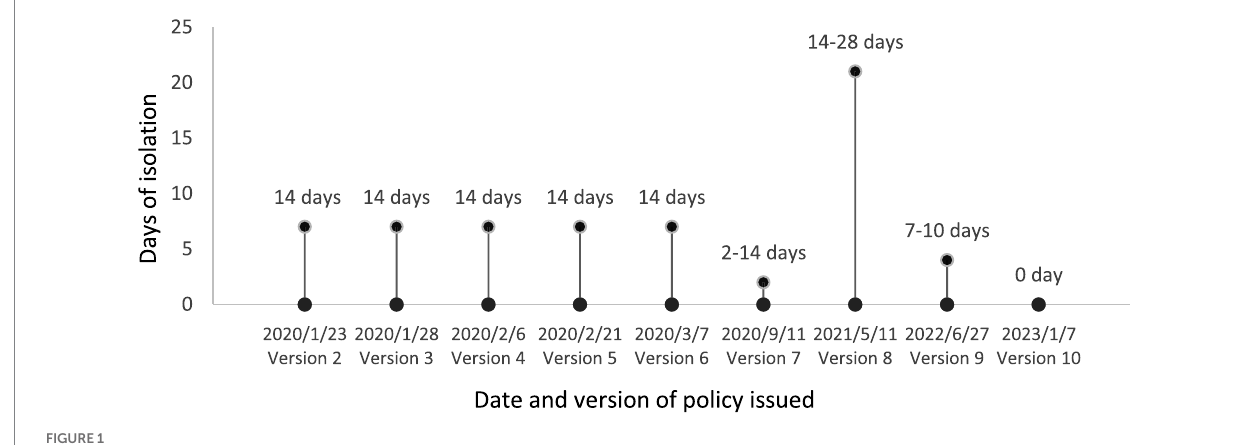
FIGURE 1 Duration of mandatory hotel/home quarantine for incoming passengers according to the 2nd–9th editions of the COVID-19 prevention and control